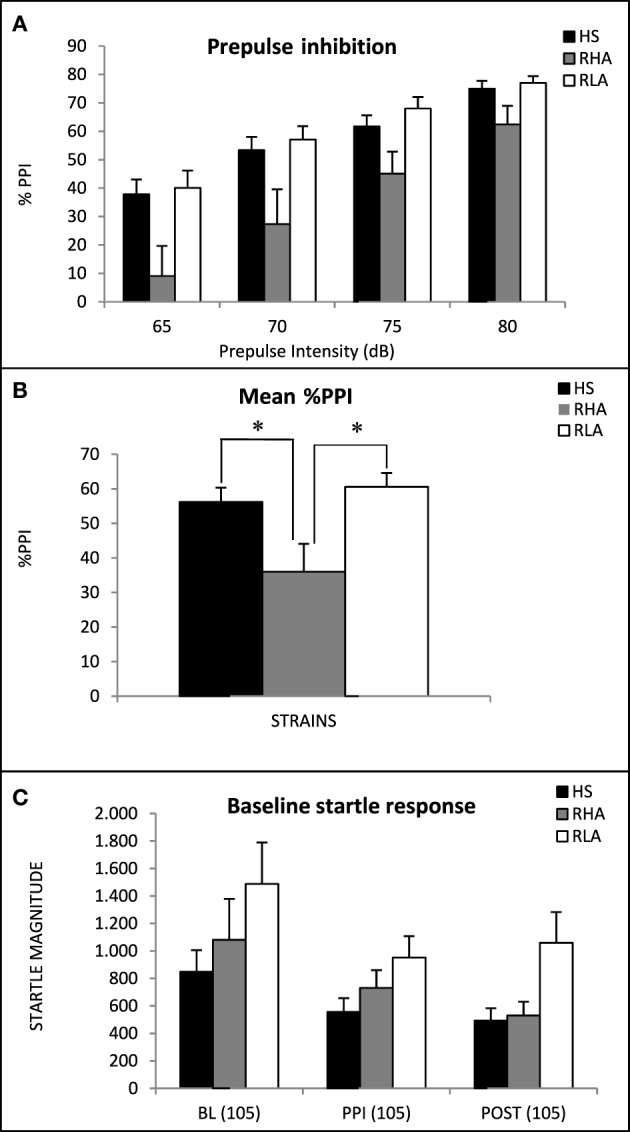
(A) Mean prepulse inhibition (± S.E.M.) is shown for the three strains. (B) Mean ± S.E.M. of the “Mean %PPI” averaged for the four prepulse intensities. (C) Mean ± S.E.M. of the startle response in the three blocks of pulse-alone trials: BL(105), initial pulse-alone 10-trial block; PPI(105), second pulse-alone 10-trial block, pseudorandomly administered in combination with presentation of the prepulse-pulse trials; POST(105), the final pulse-alone 5-trial block. *p < 0.05 between the indicated groups (LSD tests).